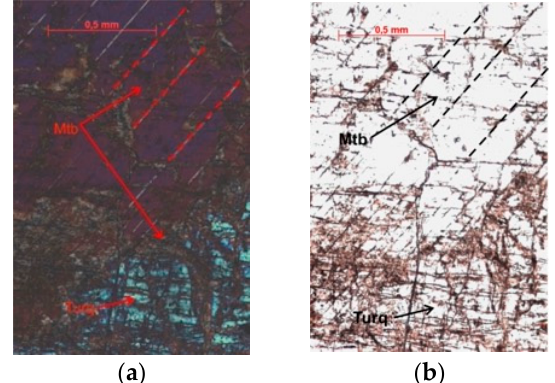
Figure 5. Microphotography of the quartz montebrasite hydrothermal vein. ( a ) Cross-polarized light of montebrasite (Mtb) with polysynthetic twinning and turquoise (Turq). ( b ) Plane polarized light of montebrasite (Mtb) with polysynthetic twinning and turquoise.